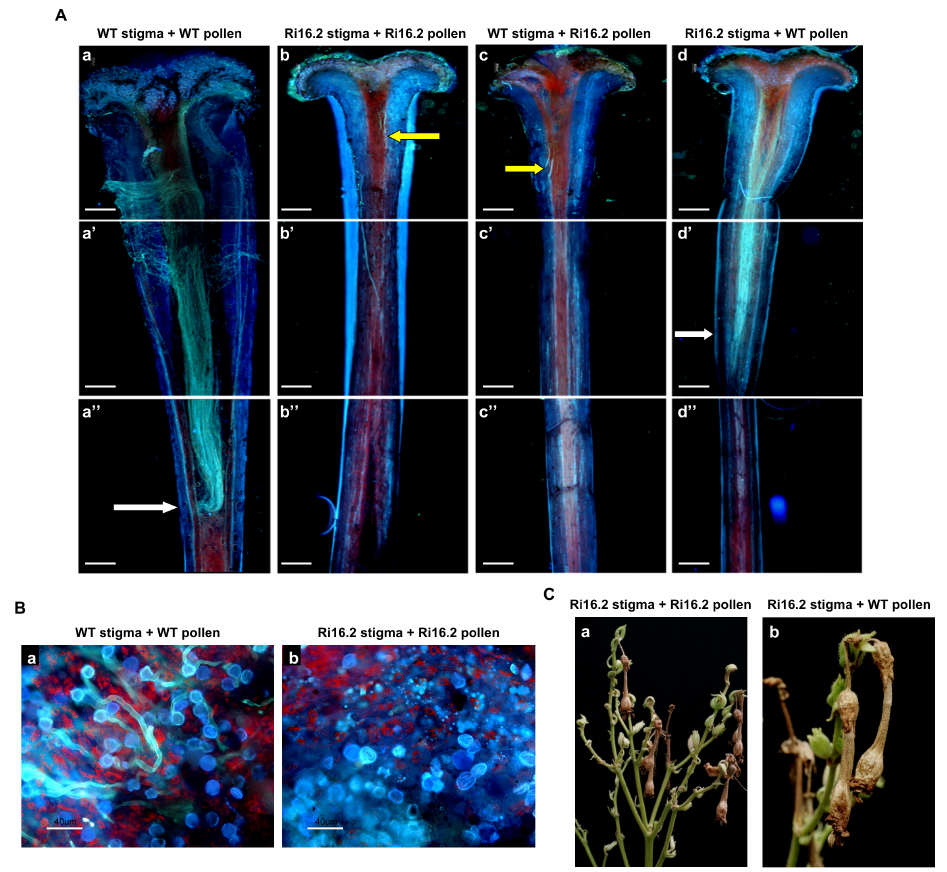
Figure 5. Microscopic analyzes show the impairment of pollen grains from plants with the silencing of NtPAE1. ( A ) Fluorescence microscopy of wild type and PAERi-16.2 (silencing) pistils at stage 11 of flower development stained with aniline blue. ( a – a” ) self-pollination of wild type plants; ( b – b” ) self-pollination of PAERi-16.2 silencing plant; ( c – c” ) cross-pollination of wild type stigma with pollen from PAERi-16.2; ( d – d” ) cross-pollination of PAERi-16.2 stigmas pollinated with wild type pollen. White and yellow arrows show the tips of the pollen tubes after 7 h of pollination. White bars = 800 µm. ( B ) Details of pollen tube growth in self-pollination of ( a ) wild type and ( b ) PAERi-16.2 plants. Bar = 40 µm. ( C ) Inflorescence and fruits of PAERi-16.2 transgenic plant. ( a ) Self-pollinated; ( b ) cross-pollinated with wild type